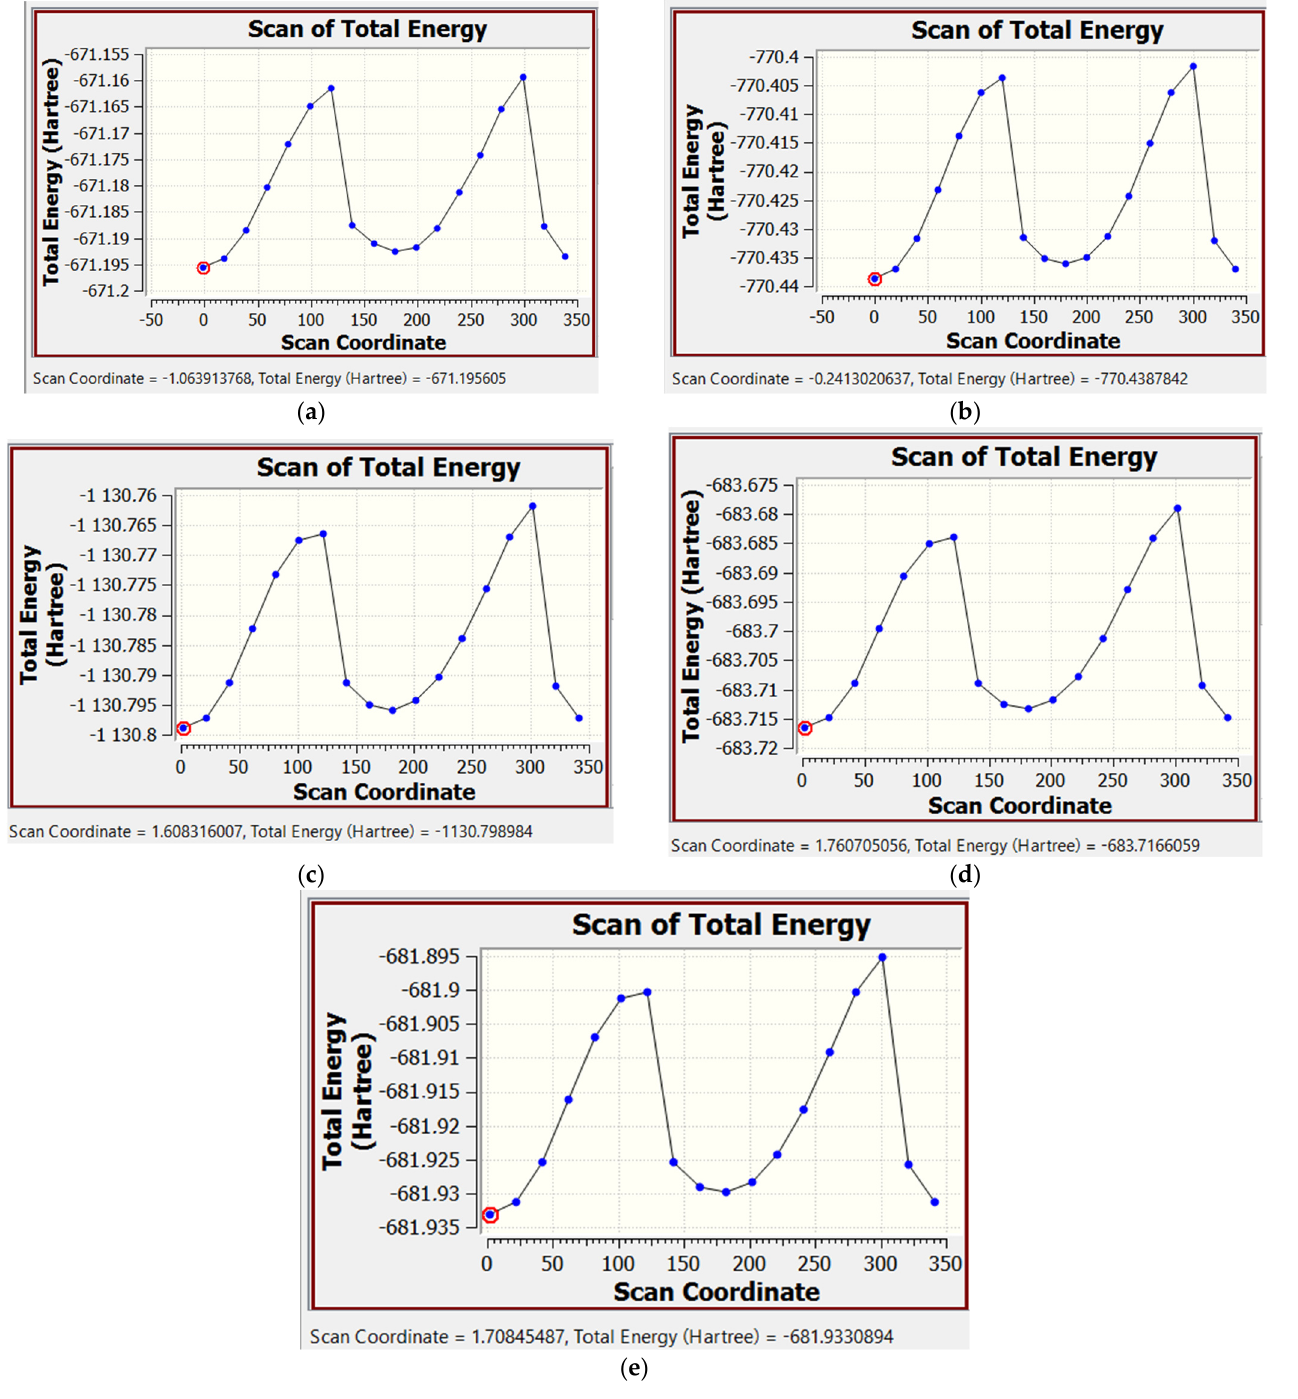
Figure 6. The energy profiles obtained by one-dimensional relaxed scanning the PES on variation in the torsion angle O=C-N-CH for compounds BHFA ( a ), BHFA-oF ( b ), BHFA-oCl ( c ), BHFA-oBr ( d ), and BHFA-oI ( e ) with a step of 20°. At each step, the remaining geometric parameters of the molecules were completely optimized in the M06-2X/6-311+G*/IEFPCM(DMSO) approximation.